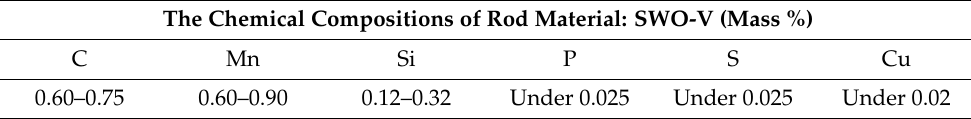
Table 2. Chemical composition and material property of the SWO-V